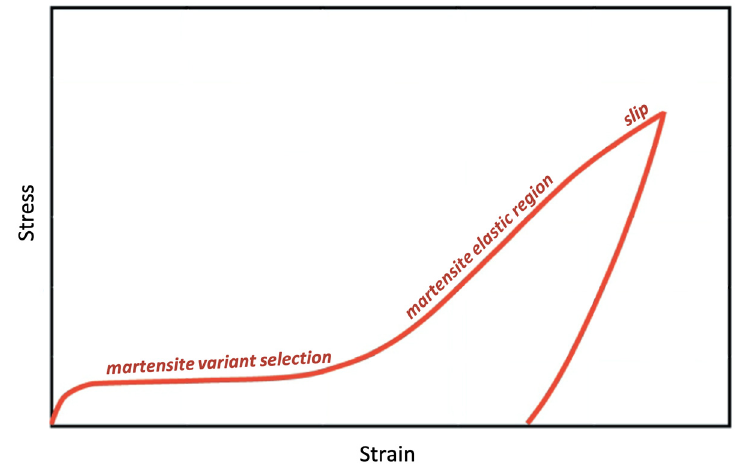
Figure 3. Stress–strain curve illustrating the various yield regions.